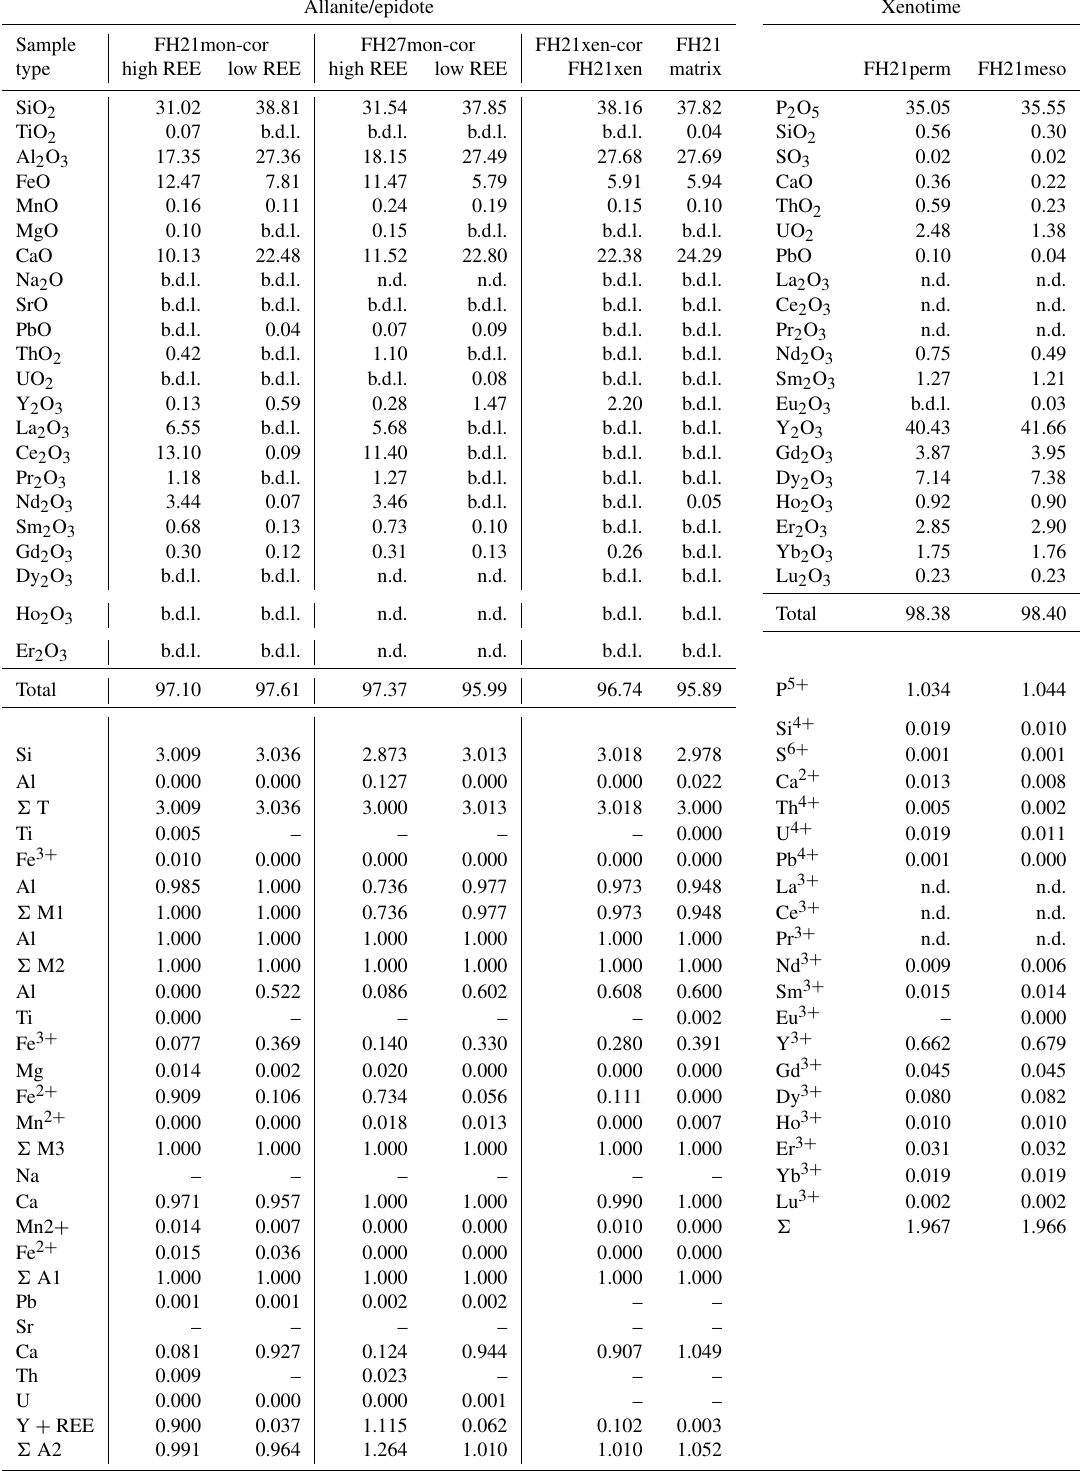
Table 4. Representative allanite and xenotime analyses (top: wt.%; bottom: apfu) obtained by EMP (n.d.: not determined; b.d.l.: below detection